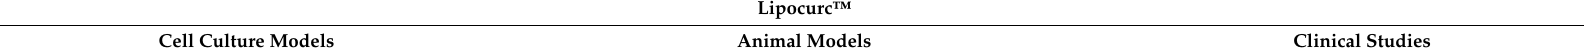
Table 4. E ff ects of Lipocurc ™ obtained in vitro, in vivo and in clinical trials.